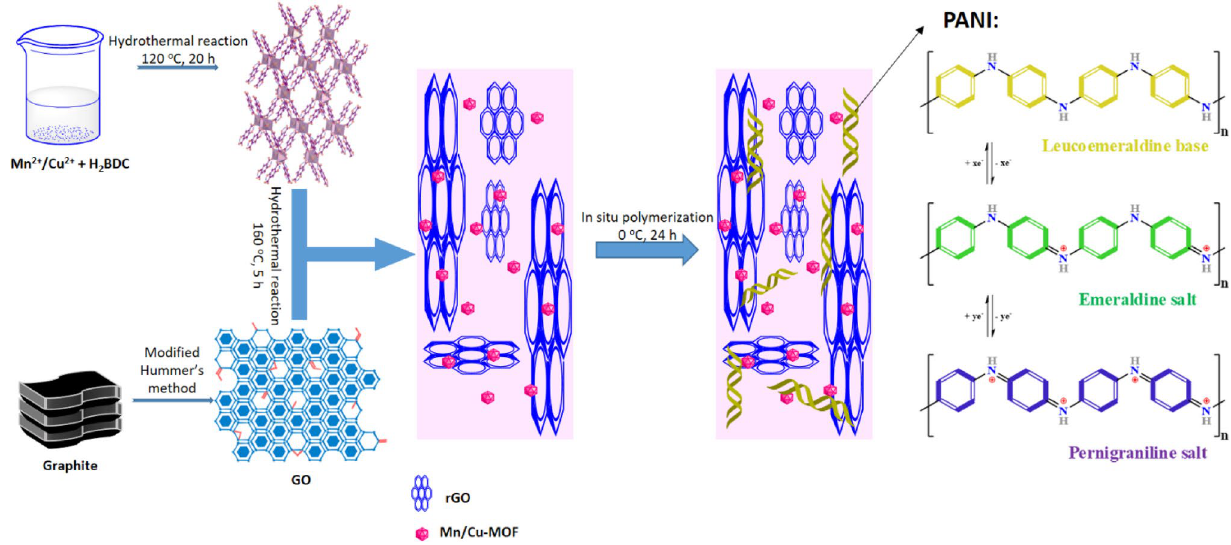
Figure 1. The fabricated supercapacitor based on rGO, Cu/Mn-MOF, and